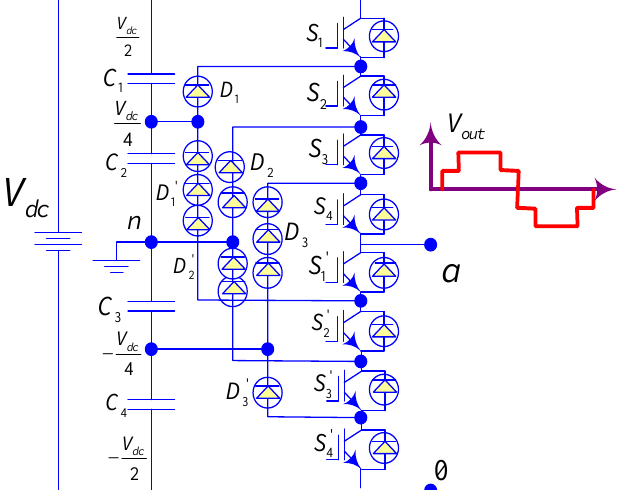
Figure 5. Circuit topologies for 5-leveldiode-clamped multilevel inverters.